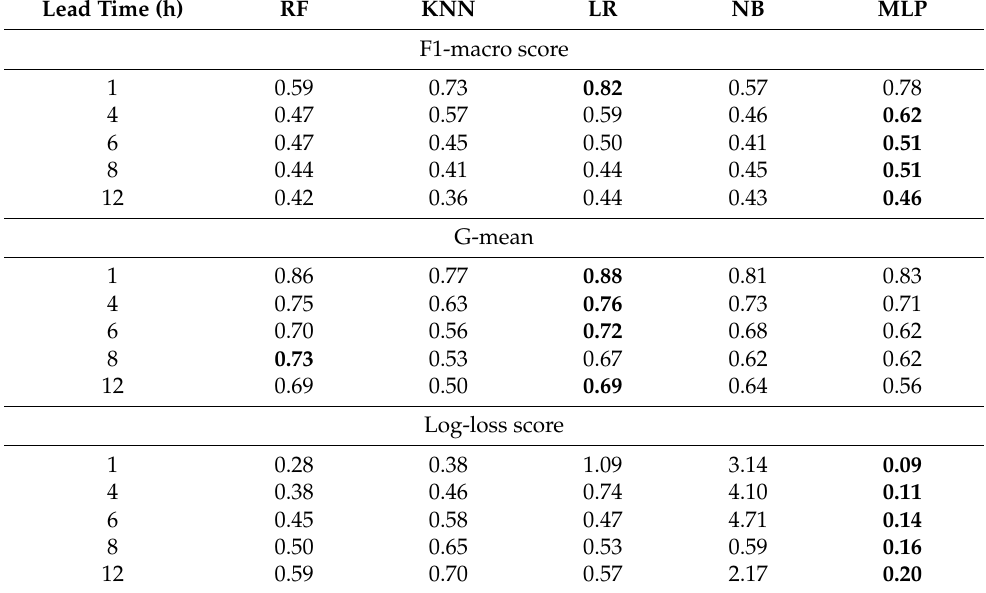
Table 5. Models’ performance evaluation on the test subset. Bold fonts indicate the best performance for a given lead